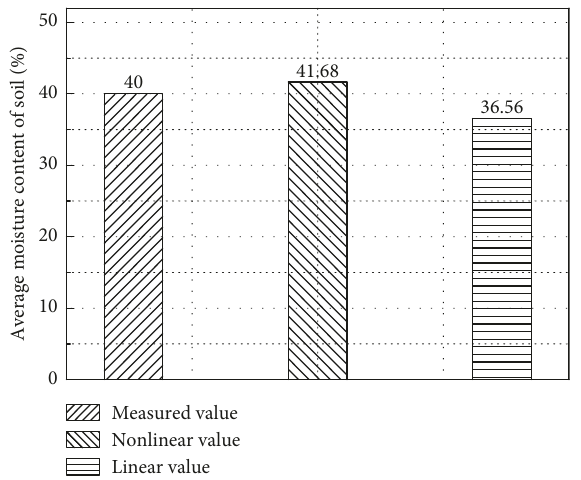
Figure 11: Average moisture content in the soil at t �